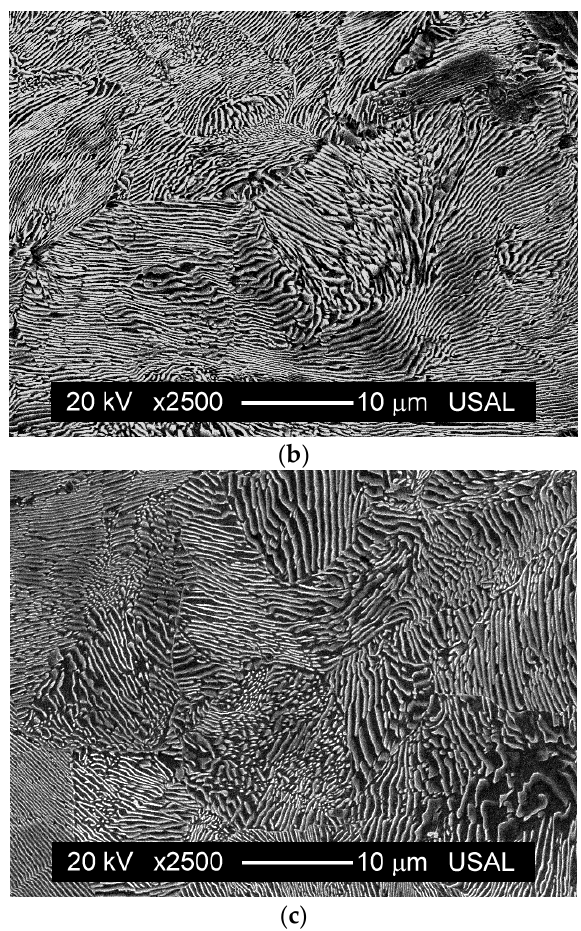
Figure 1. Pearlitic microstructure in steels cooled using: ( a ) air-cooling at room temperature, AC; ( b ) partially opened furnace, POF; ( c ) fully closed furnace, FCF.